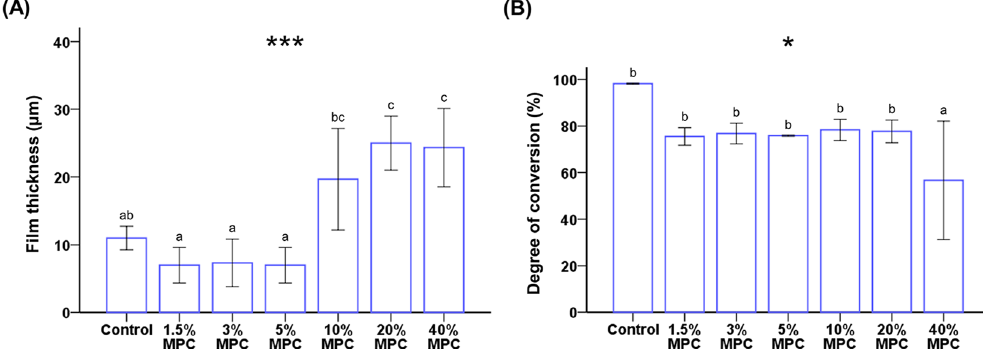
Figure 1. Comparison of the mean film thickness ( A ) and degree of conversion ( B ) between groups. Different letters above bars indicate significant differences. * P < 0.05, *** P < 0.001 for comparisons between LCFV with different concentrations of MPC.